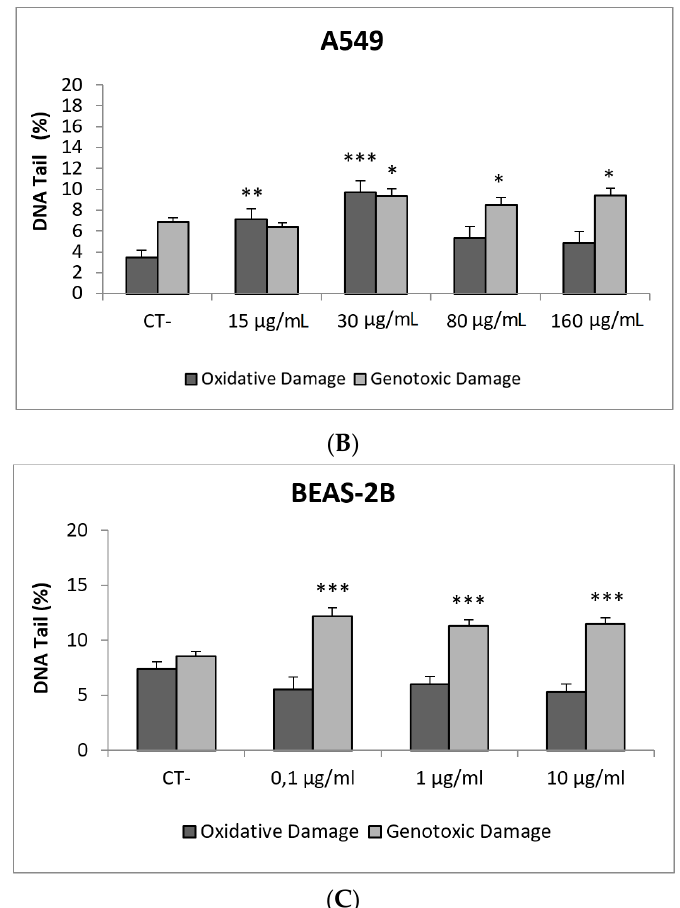
Figure 8. Results from the AgNPs (NM300K), on A549 and BEAS-2B cells. ( A ) Toxicity curves for both cell lines. ( B ) Genotoxicity results obtained in A549 cells. ( C ) Genotoxicity results obtained in BEAS-2B cells. Genotoxicity data are plotted as mean ± SEM of two independent experiments. * p ≤ 0.05, ** p ≤ 0.01, *** p ≤ 0.001 (one way-ANOVA). CT, control.